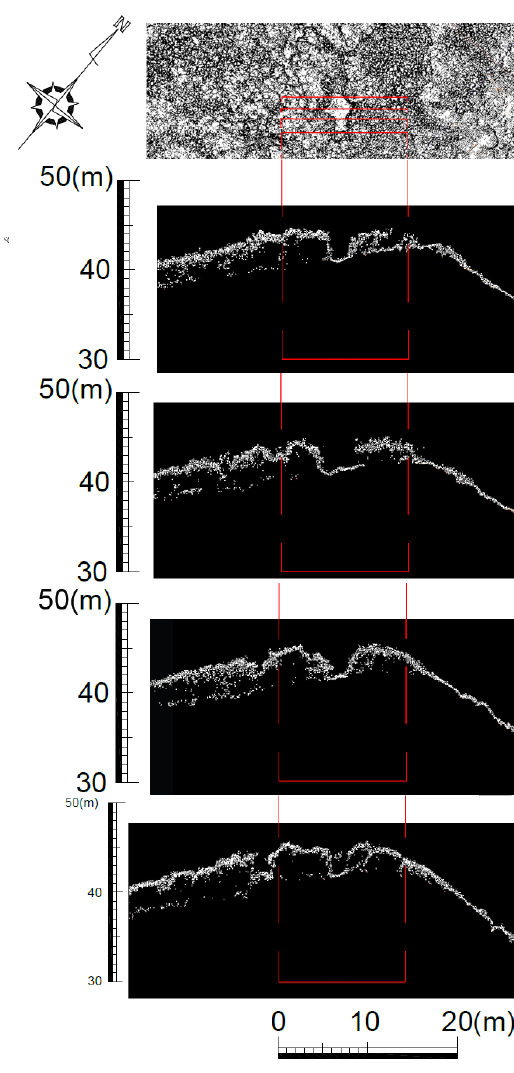
Fig.8 Stone chamber structure analysis of the top by point cloud data Diagram The four on the left are cross-sections along the main axis arranged from the northeast. The three on the right are cross- sections orthogonal with the spindle line arranged from the northwest